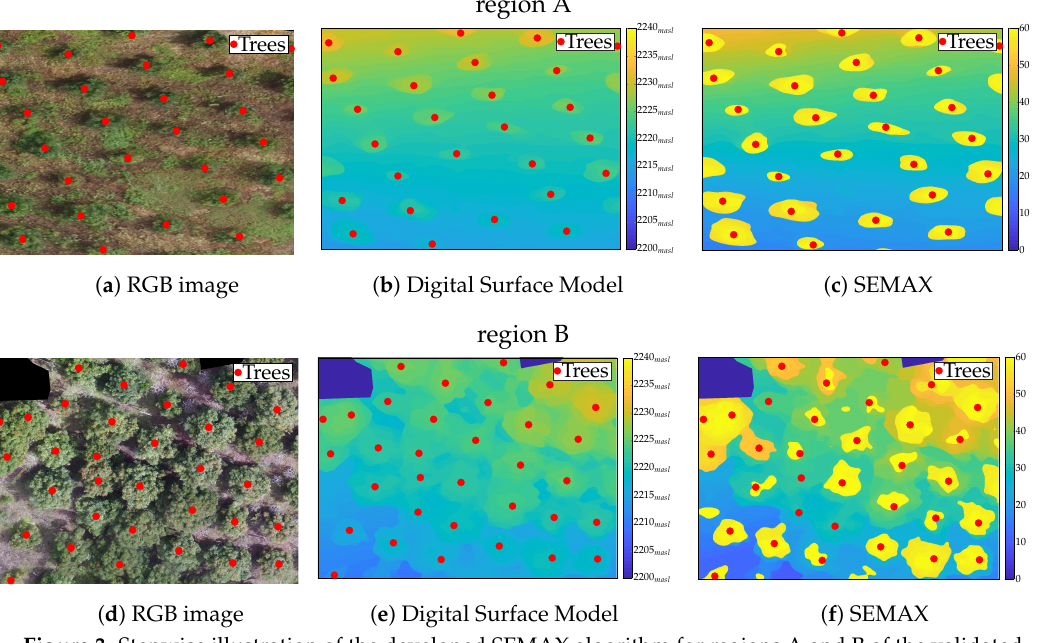
Figure 3. Stepwise illustration of the developed SEMAX algorithm for regions A and B of the validated Orchard